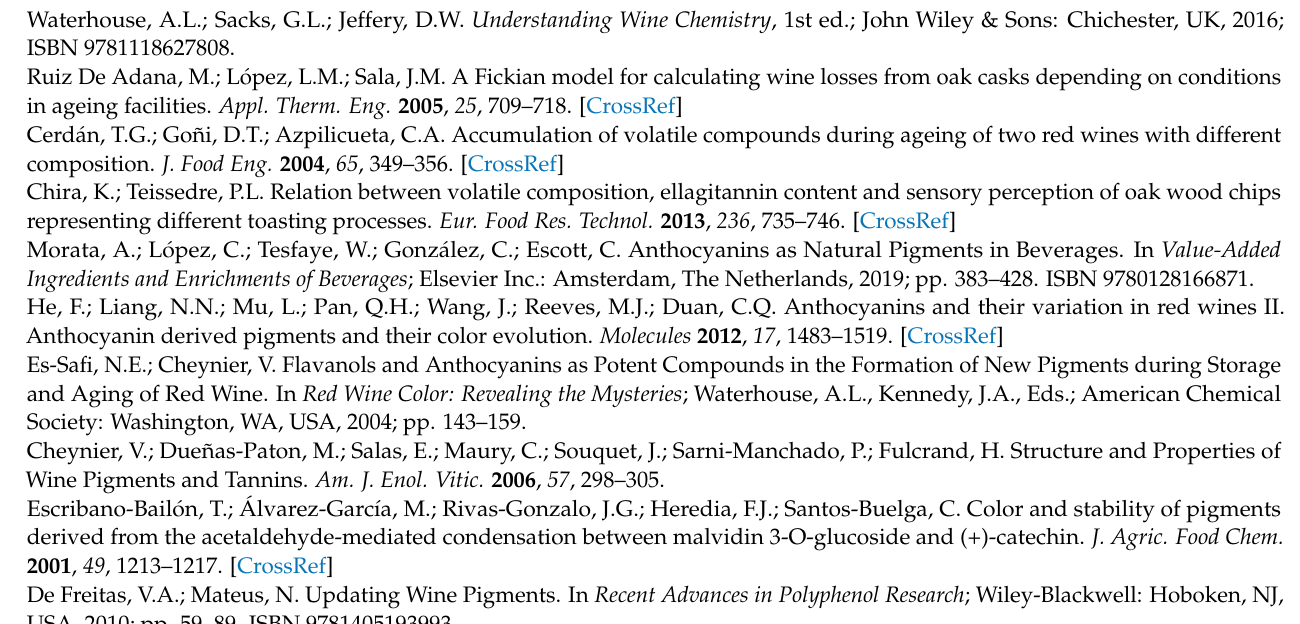
precision. Figure S1: color, pigments of red wines after 12 months of aging in oak barrels displayed in boxplots for cooperage A, B, C, and D, as well as the bottle matured wine. Figure S2: phenolic composition of red wines after 12 months of aging in oak barrels displayed in boxplots for cooperage A, B, C, and D, as well as the bottle matured